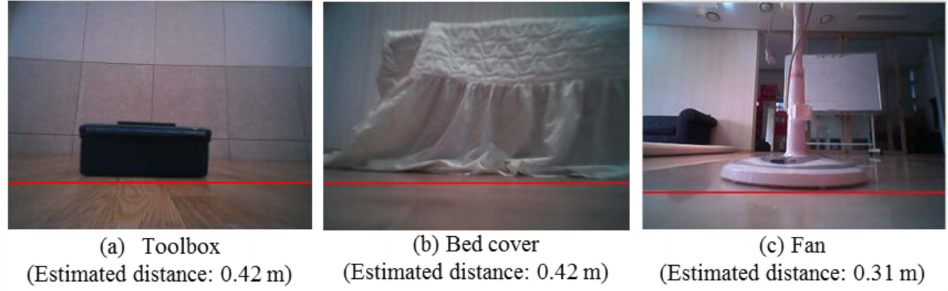
Figure 8. Estimated horizontal border lines that pass through the lower pixels of the